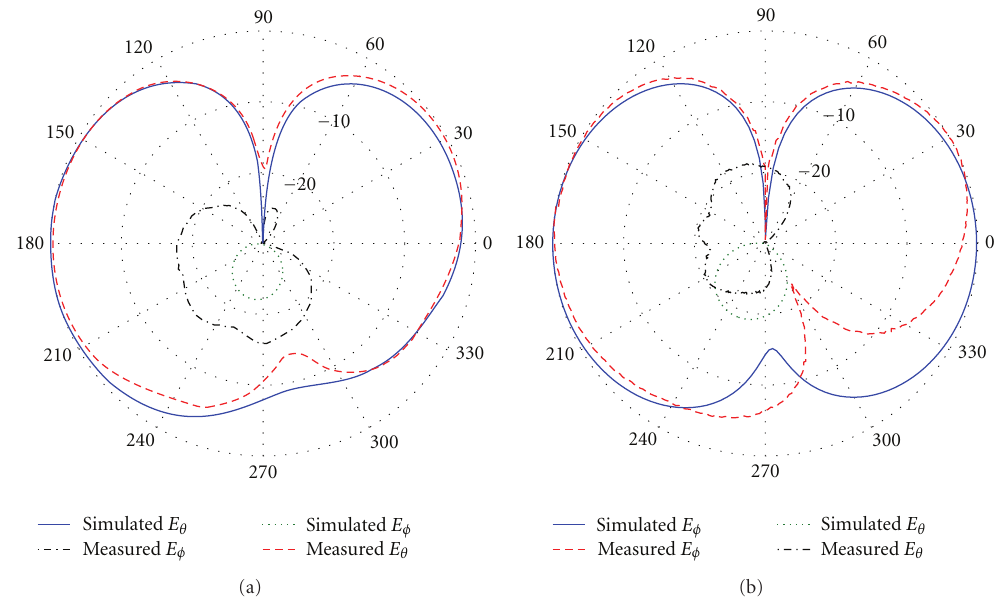
Figure 6: Comparison between simulated and measured radiation patterns for the HEM 11 δ mode at 2.6GHz when the di ff erence mode is activated (a) XZ plane (b) YZ plane, in dB units.